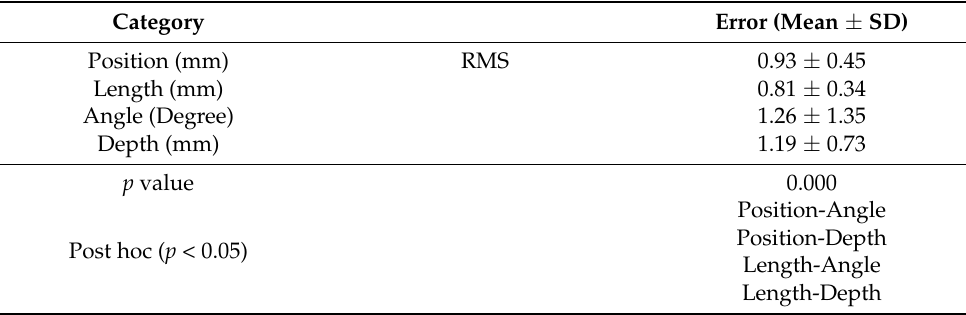
Post hoc ( p < 0.05)